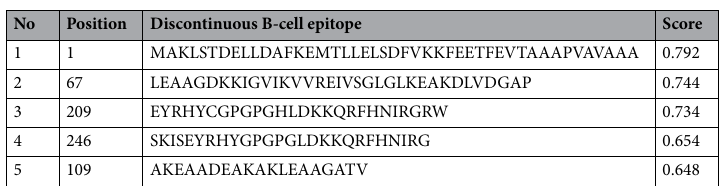
No Position Discontinuous B-cell epitope